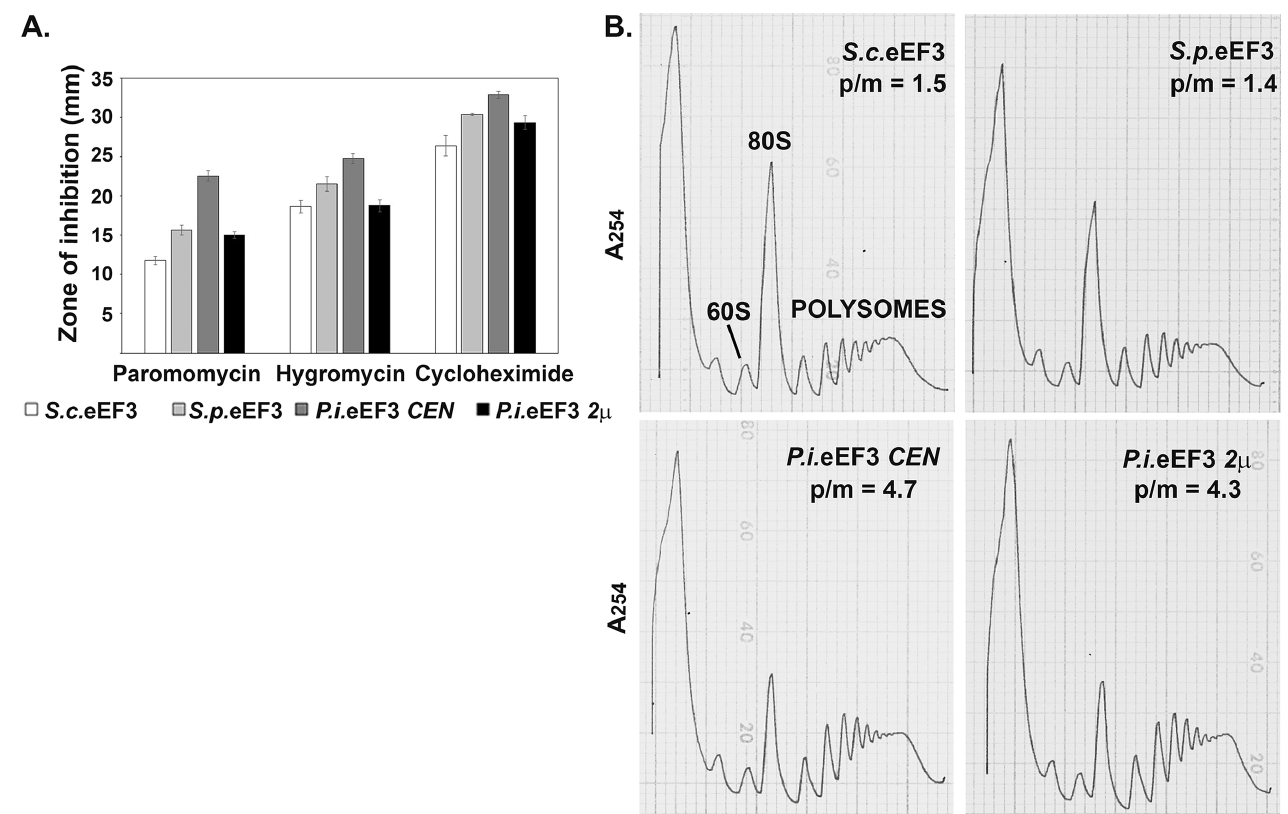
Fig 4. Strains expressing P . infestans eEF3 show defects in translation elongation and/or termination. (A) Antibioticsensitivity was determined by measuring the diameterof the zone of growth inhibition arounda disk containing 10 μ L of the indicateddrug: Paromomycin (800 mg/ ml), hygromycin(25 mM), and cycloheximide (1 mM). The graph representsthe averageof three experiments and error bars representingthe standarderror are shown. (B) Ribosome extracts were preparedfrom the indicatedstrains in the absenceof cycloheximide. Extracts were analyzed by 7–47% sucrose density gradientcentrifugation and representative A 254 traces are shown. The area under the 80S and polyribosome peaks was analyzedusing Image J and the ratio of polyribosomes to monosomes(p/m) is indicatedfor each strain. S . cerevisiae(S . c . ) , S . pombe(S . p . ) , and P . infestans (P . i . )